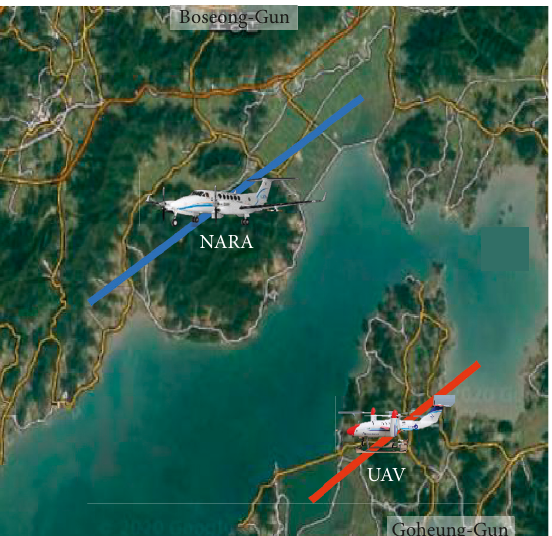
Figure 2: Target area and flight path of seeding by the UAV (red) and observation by the NARA (blue) over the southern part of the Korean peninsula on April 25, 2019.